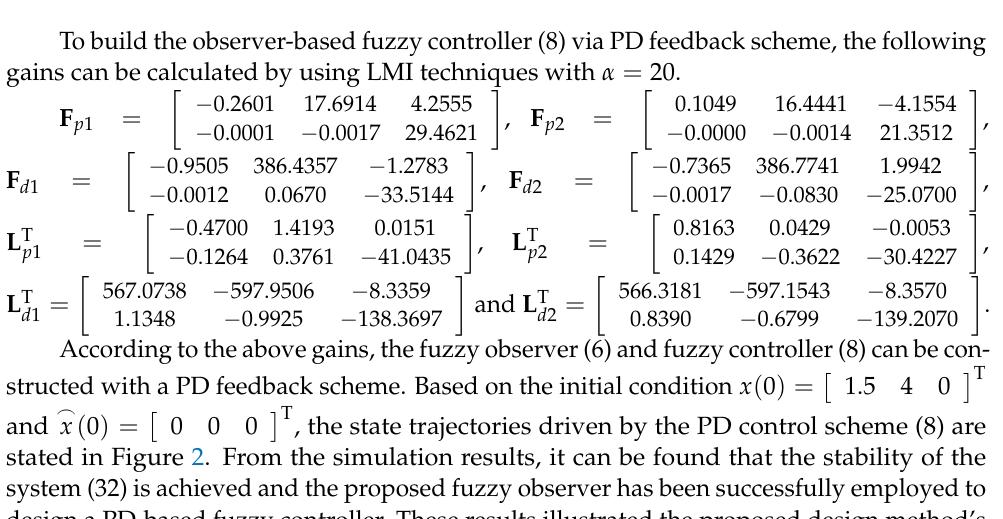
Figure 1. Membership functions